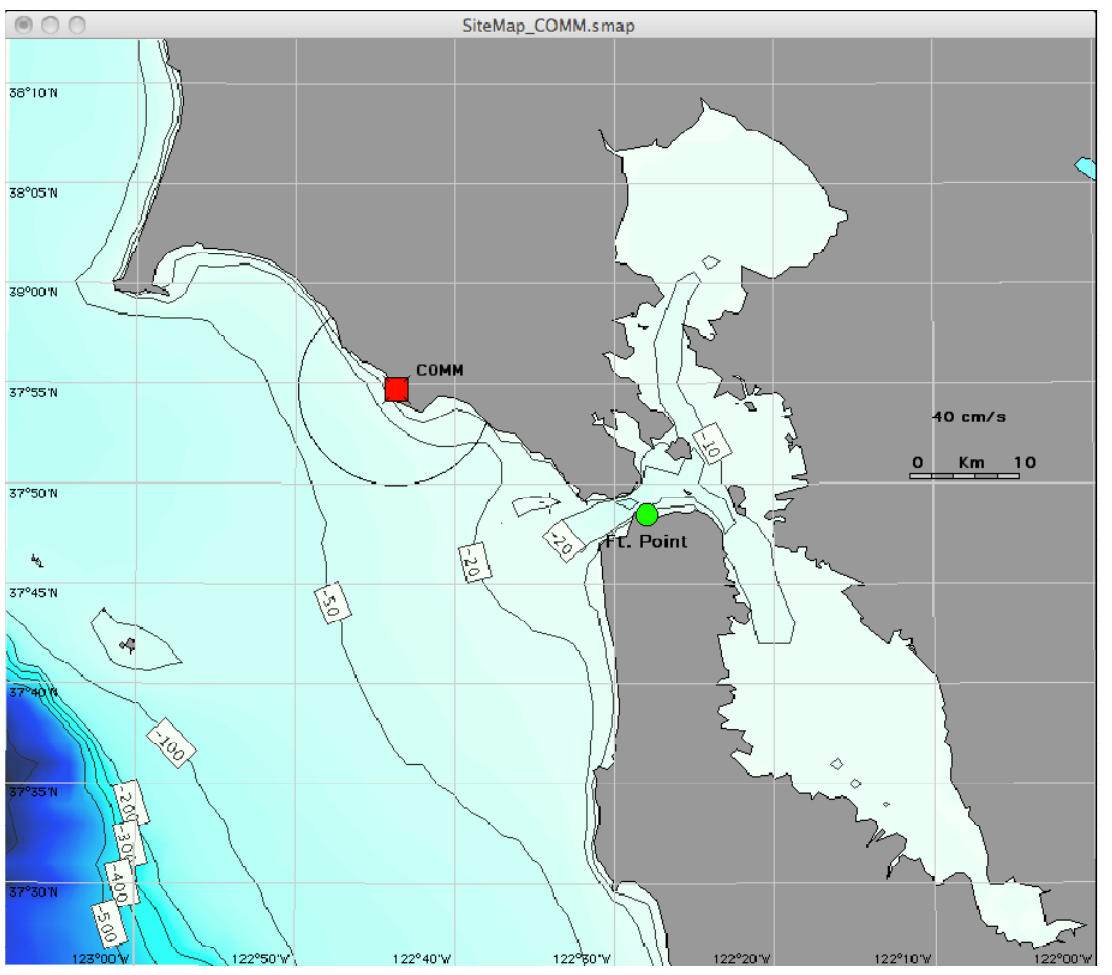
Figure 9. The location of the radar near Bolinas, California, the tide gauge at Fort Point and the offshore bathymetry. Also marked is a circular radar range cell used in the centroid frequency